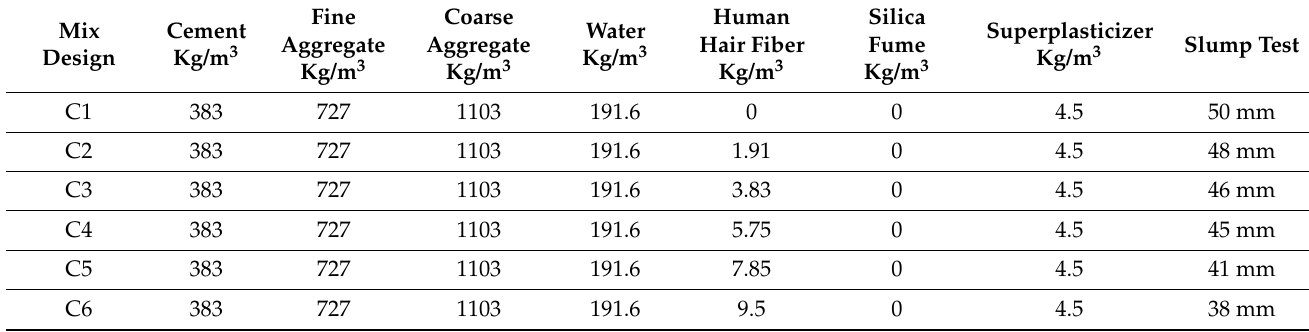
Table 4. Defining Cases for Each Mix Design